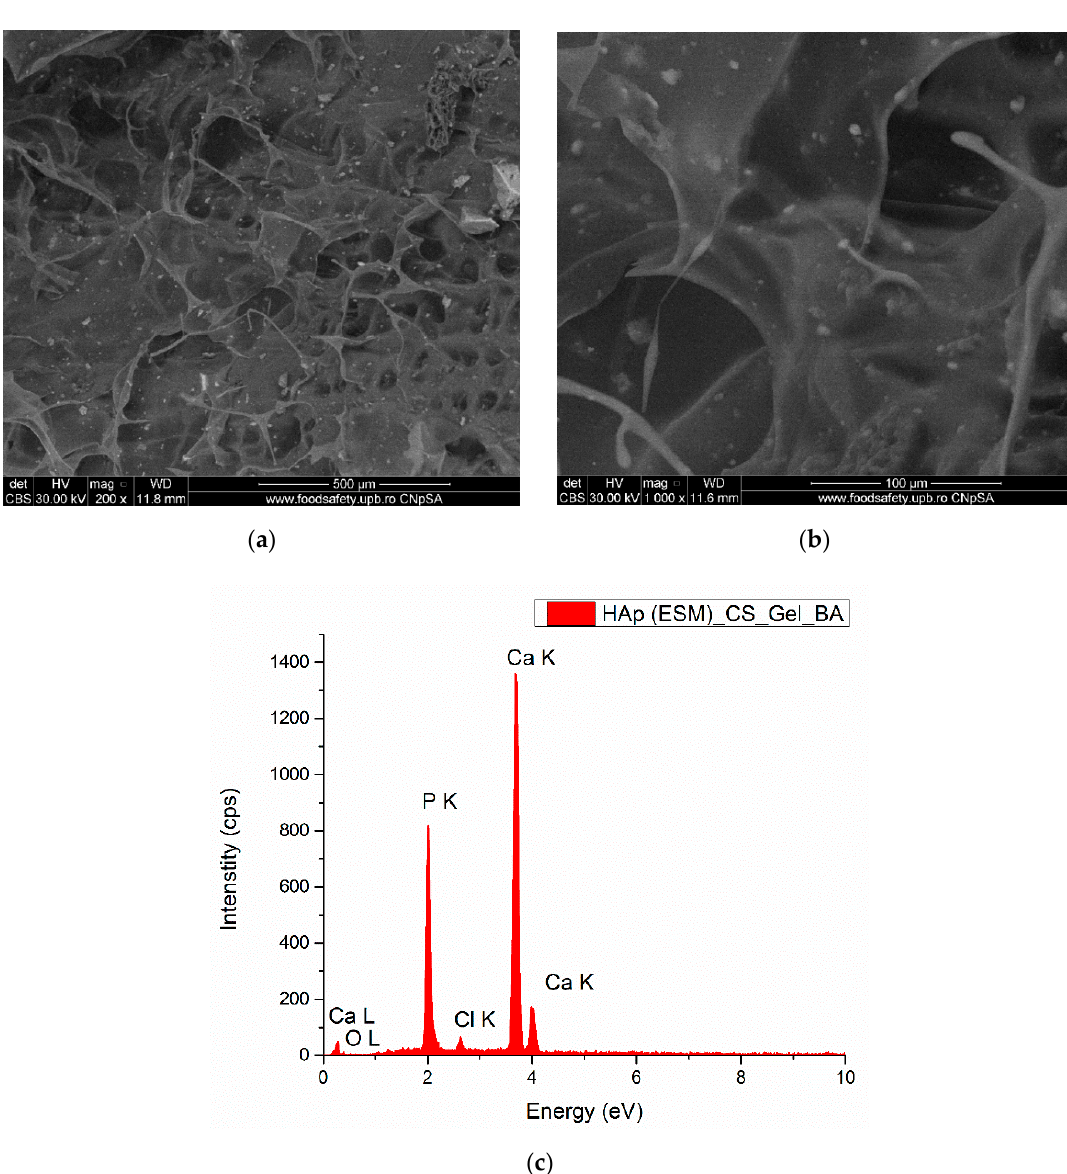
Figure 8. SEM micrographs ( a, b ) and EDS spectrum ( c ) of the composite scaffold— Hap(ESM)_CS_Gel_BA.